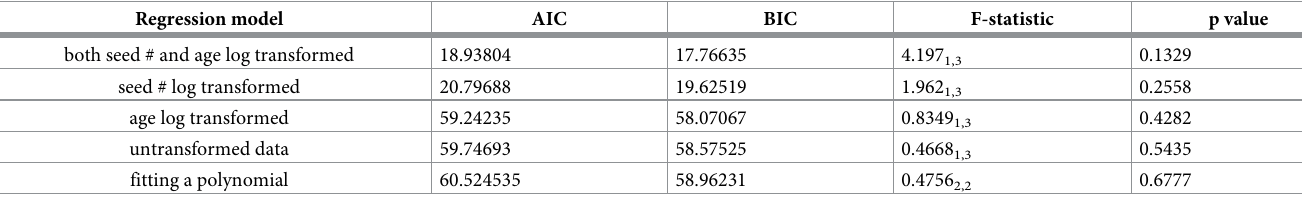
Table 2. Linear model fits to seed bank germination